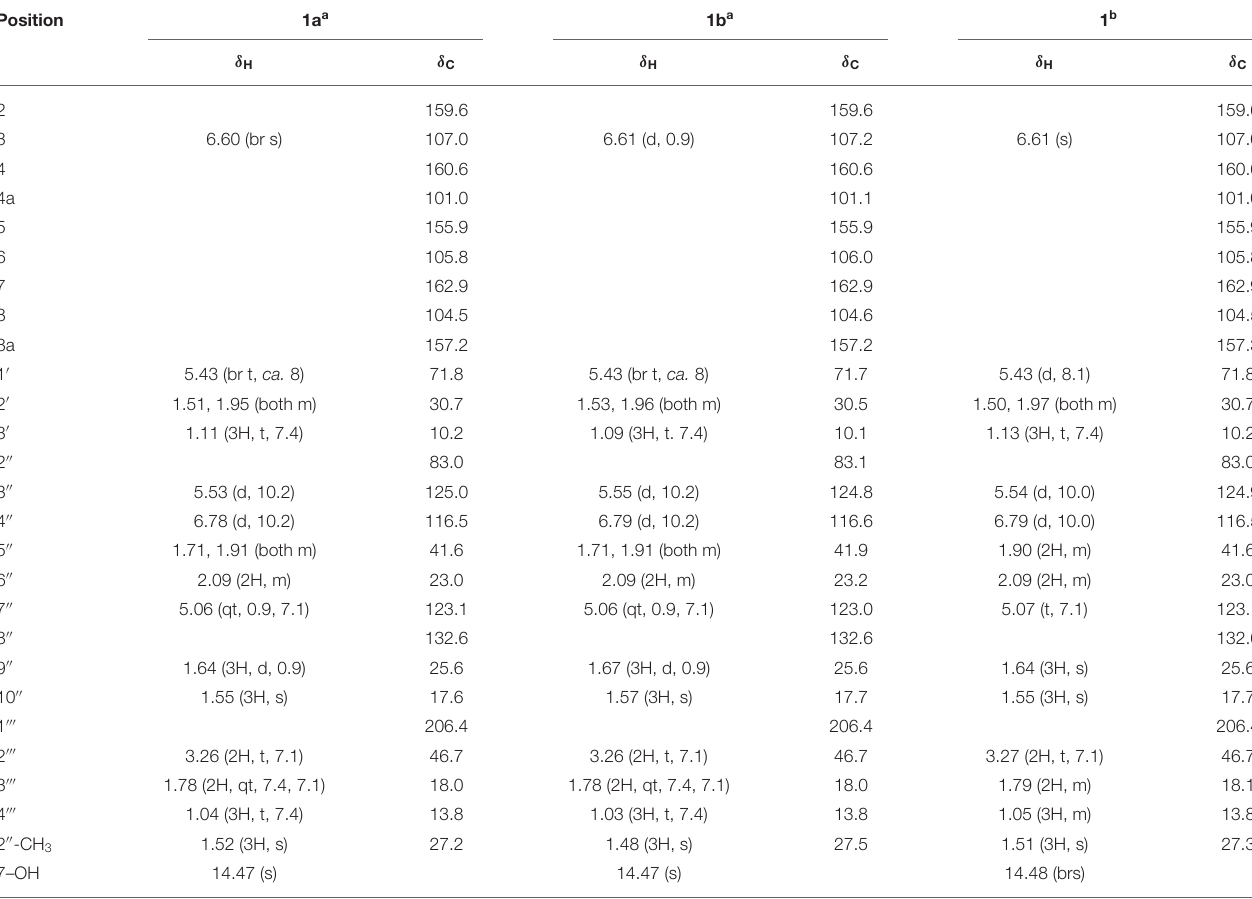
TABLE 1 | 1 H and 13 C NMR spectroscopic data (CDCl 3 ) for kayeassamin I ( 1 ).